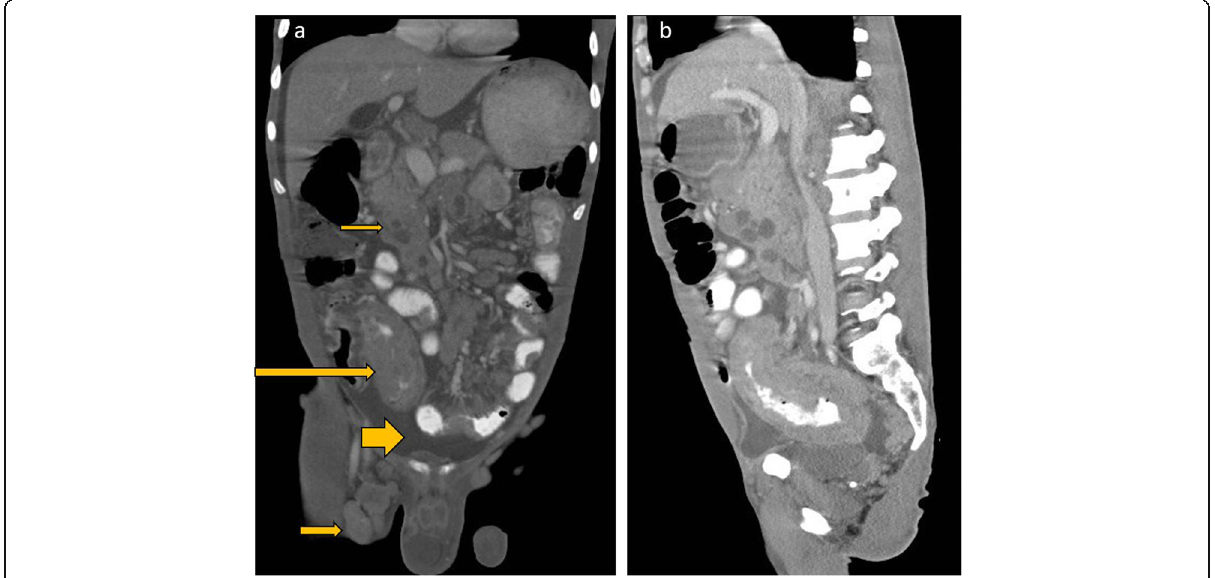
Fig. 2 Coronal reformats of a CECT abdomen and pelvis of a recently diagnosed HIV-positive patient who presented with abdominal pain, diarrhea, and weight loss show long-segment bowel thickening involving the distal ileum and caecum (long arrow). There was also mesenteric lymphadenopathy, with some necrotic nodes, (short slender arrow) and a moderate ascites (short fat arrow). There were also enlarged centrally necrotic right inguinal lymph